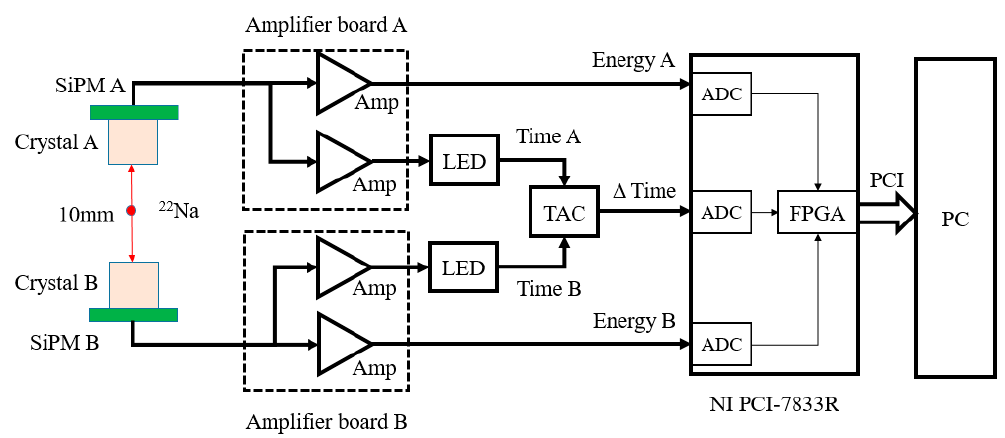
Figure 5. Schematic of the experimental setup with readout electronics.